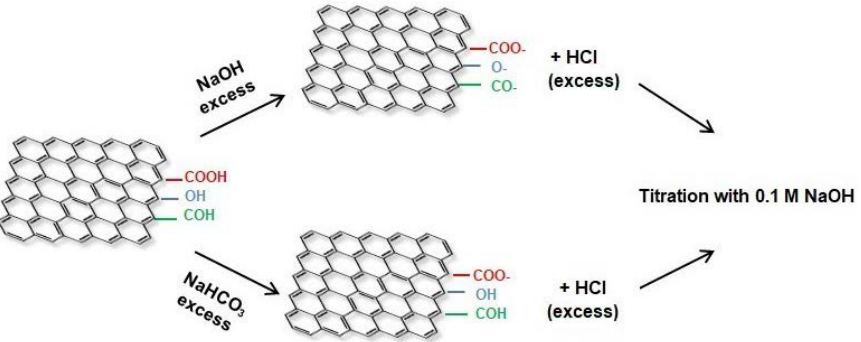
Figure 7. Scheme of the analytical method developed to titrate selectively the total acidic sites and the carboxylic groups created at MWCNT surface.